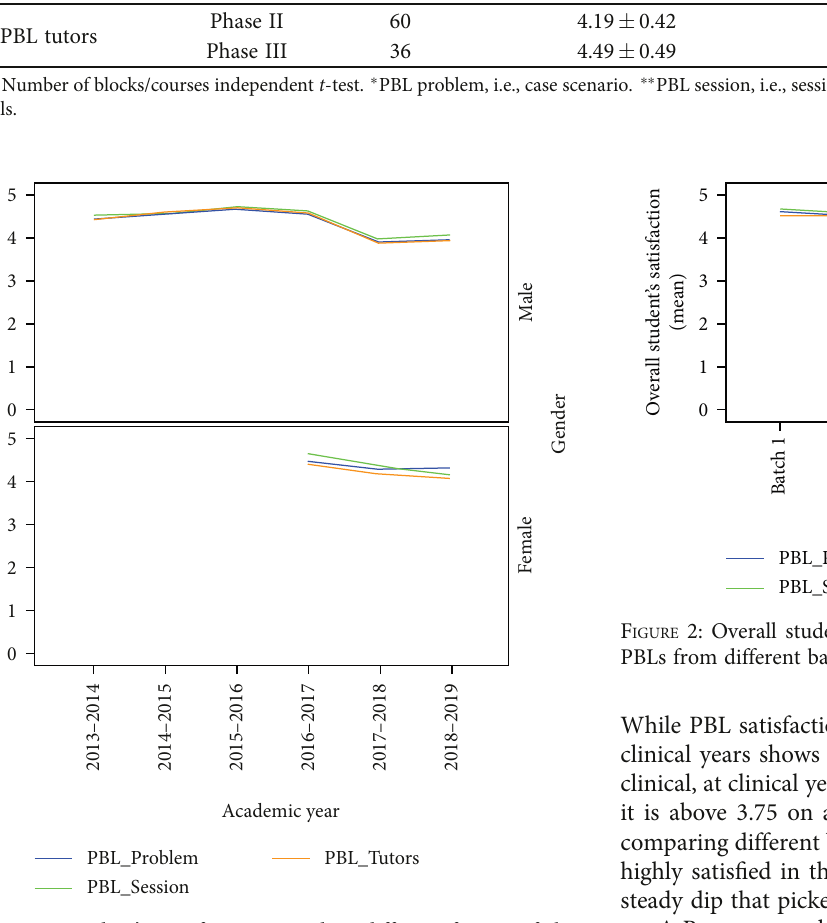
F IGURE 1: Student ’ s satisfaction regarding different factors of the PBLs based on gender from different academic years.